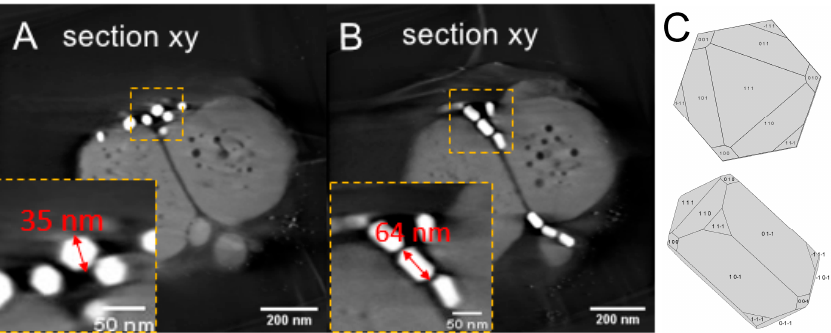
Figure 3. Spatial distribution of the magnetosomes and morphology of the crystals. ( A ) Section extracted from the reconstruction at a given depth. The perpendicular section of the crystal depicting a hexagonal contour is highlighted in the insert. ( B ) Section taken at another depth; insert, parallel section of a crystal. ( C ) Idealized model based on the observations from tomography and HRTEM images.